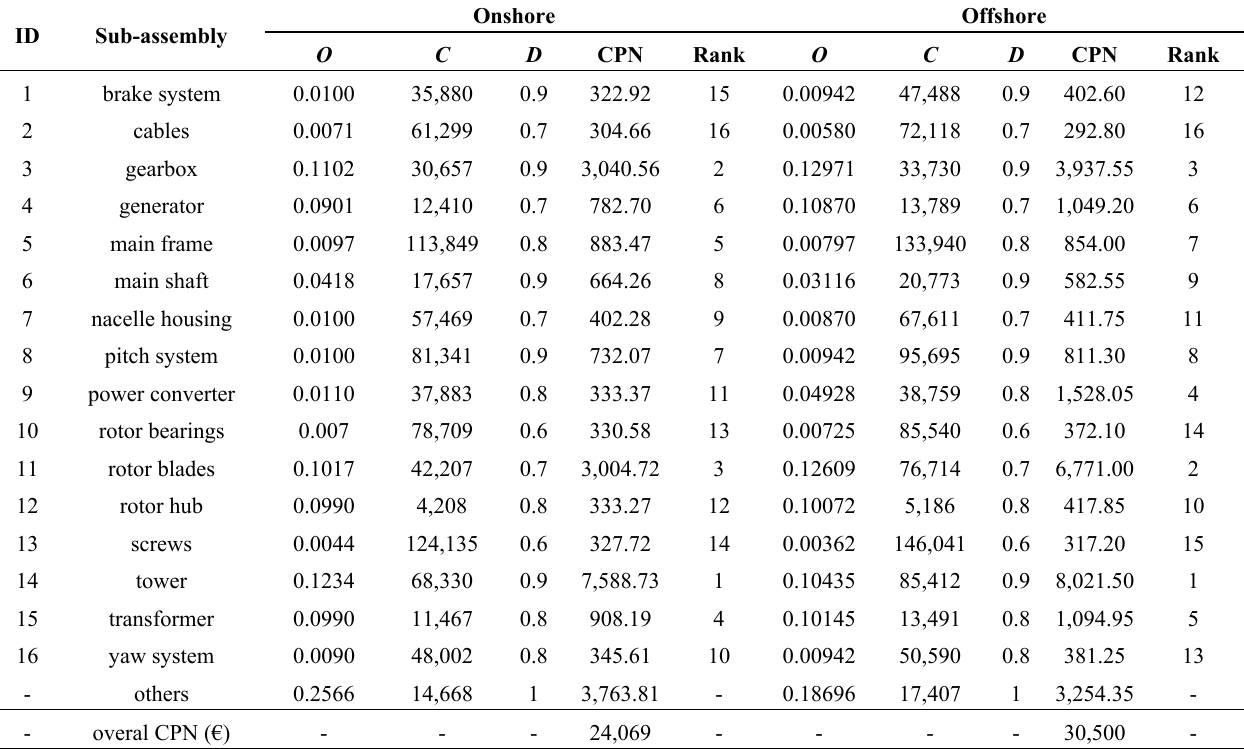
Table 8. The CPN values for the onshore/offshore wind turbine sub-assemblies (sub-assemblies are listed in alphabetical order).